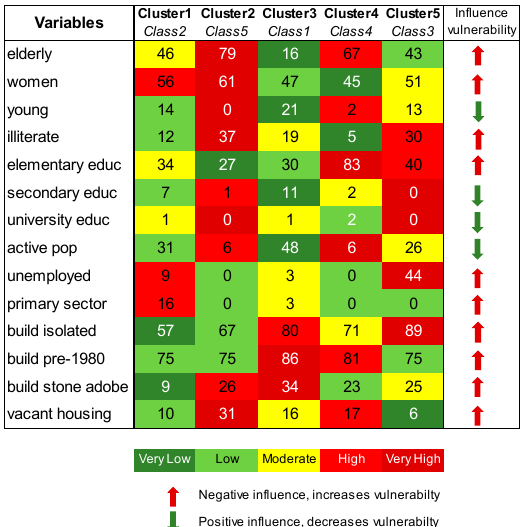
Figure 6. Mean values (%) of the variables in each cluster. Colours represent the vulnerability class that should be attributed to the cluster, considering the relative position of the values in comparison with the other clusters and the influence of the variable in vulnerability levels. The final class (1 Very Low to 5 Very High) was defined according to the number of variables with a negative or positive influence in vulnerability level, for each cluster.